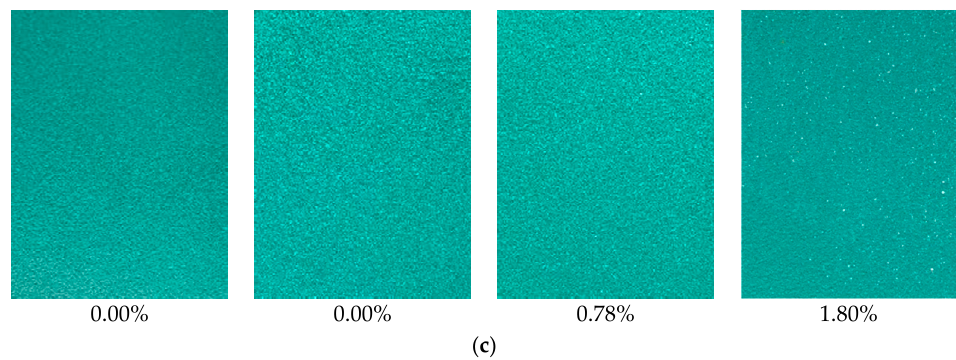
Figure 3. Appearance of coating systems (80 µm zinc rich primer with ( a ) 20 µm TC2 topcoat (Primer + TC2, non-scribe); ( b ) 20 µm TC3 topcoat (Primer + TC3, non-scribe); ( c ) 30 µm TC4 topcoat (Primer + TC4, non-scribe)) after the accelerated exposure corrosion test of two-coat system without scribe. The values indicated below the images are the percentages of white rust area over the total area.